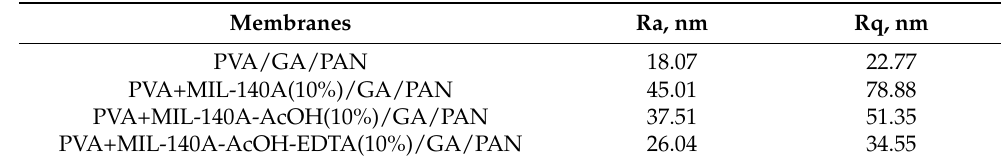
Table 6. The values of surface average (Ra) and root-mean-squared (Rq) roughness of the cross-linked composite PVA/GA/PAN and PVA/Zr-MOFs(10%)/GA/PAN membranes. Membranes